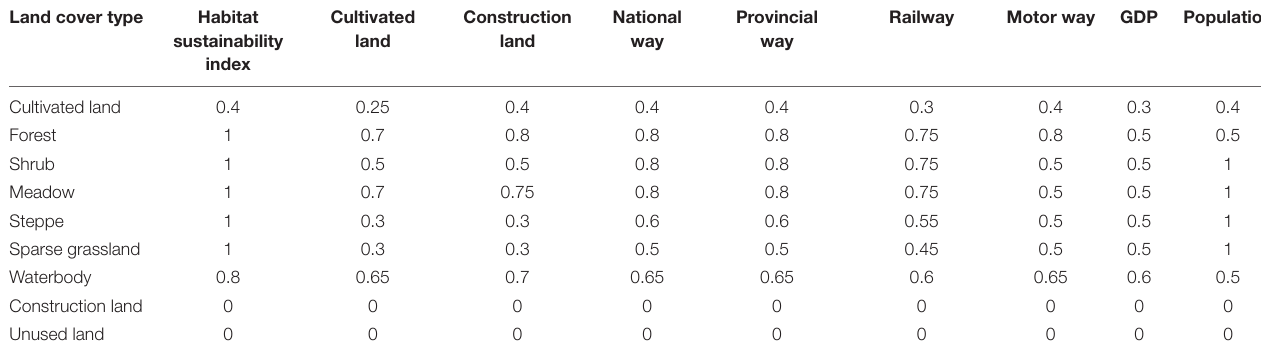
TABLE 3 | Habitat suitability of different land cover types and their sensitivity to threat factors.